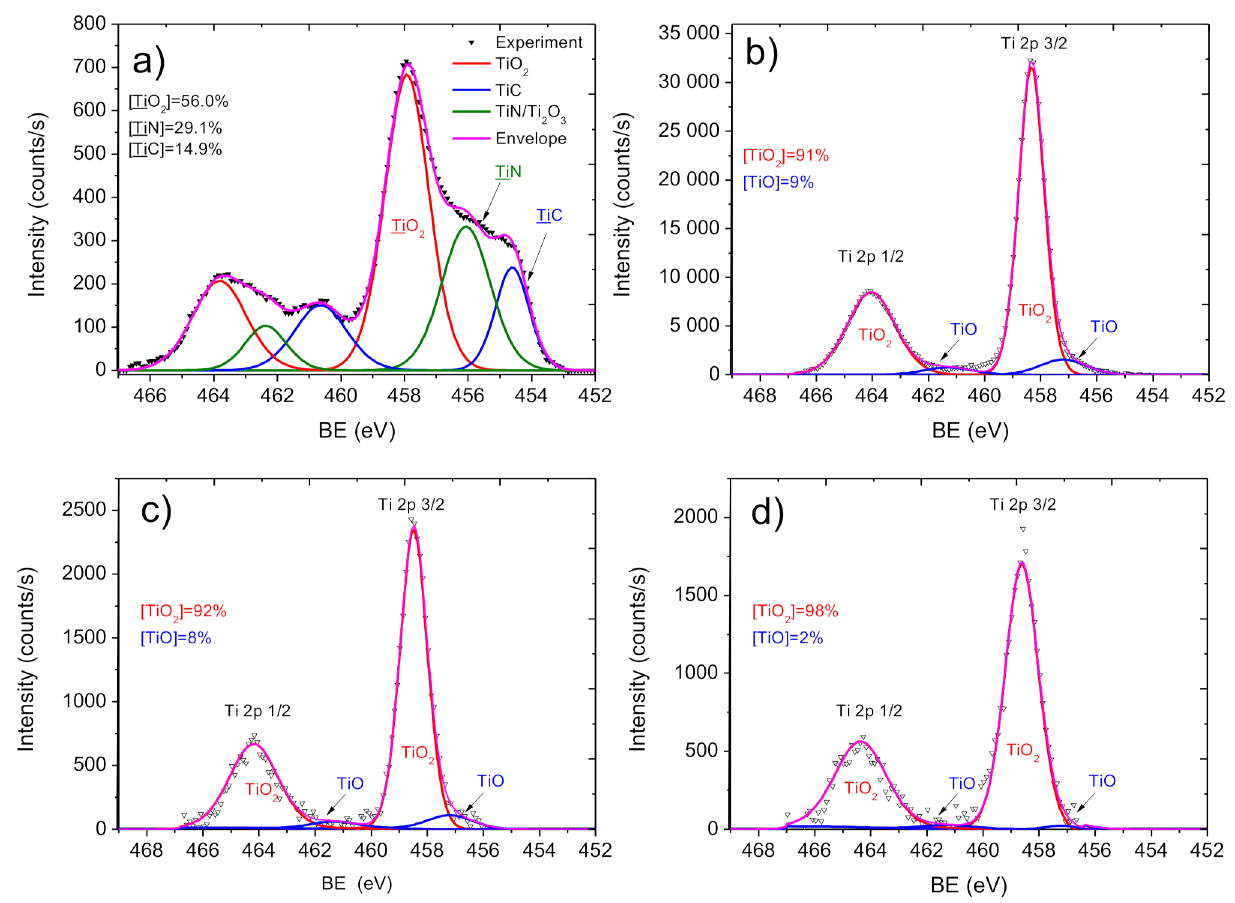
Figure 6. XPS Ti2p spectra and their curve fitting for samples PCL/PEO-Ti0.5 ( a ), PCL/PEO-Ti0.5- Ag15kV ( b ), PCL/PEO-Ti0.3-Ag5kV ( c ) and PCL/PEO-Ti0.3-Ag5kV ( d